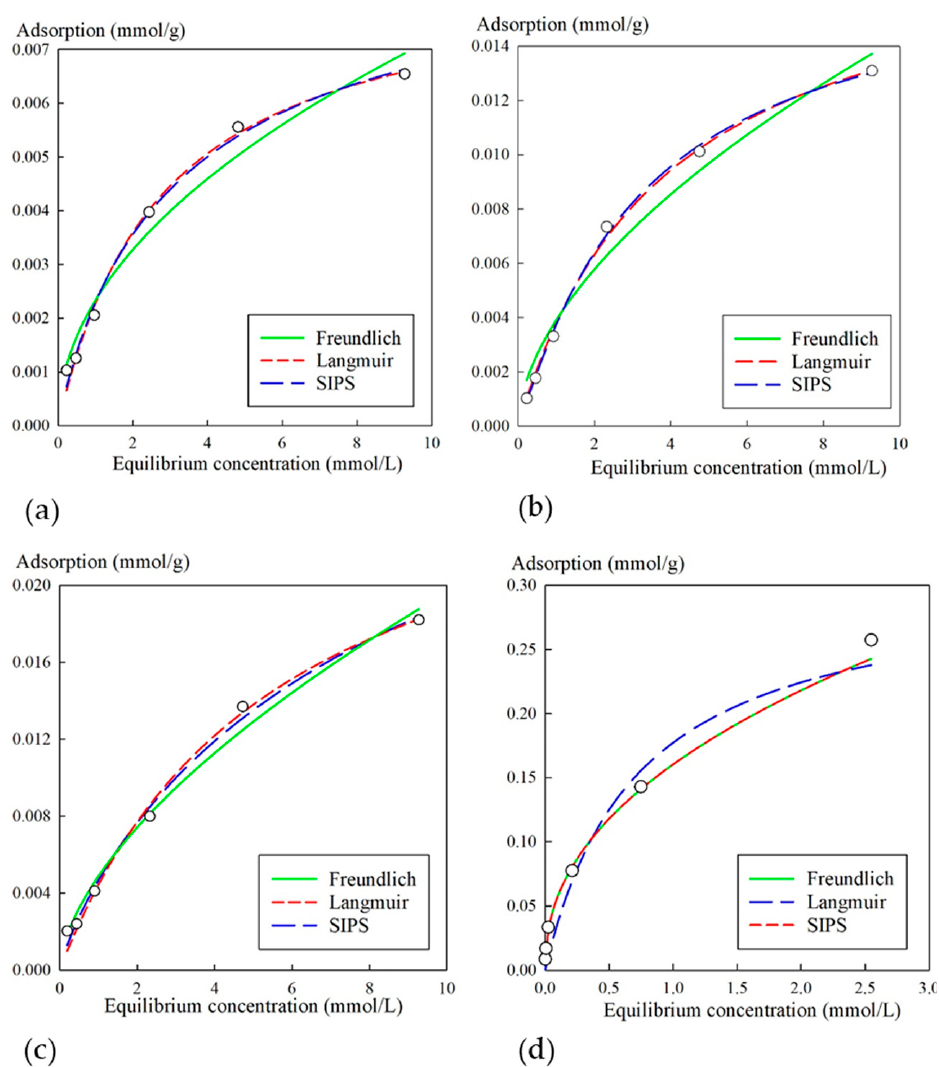
Figure 5. Isotherms of Sr 2 + sorption from NaCl solution (0.1 mol / L) for sorbents: ( a ) 3M, ( b ) 3M-2, ( c ) 3M-4, ( d ) KU-MAG. Circles represent the experimental data; fit lines were computed using the Freundlich, Langmuir, and Sips equations (Equations (2), (3), and (4), respectively).